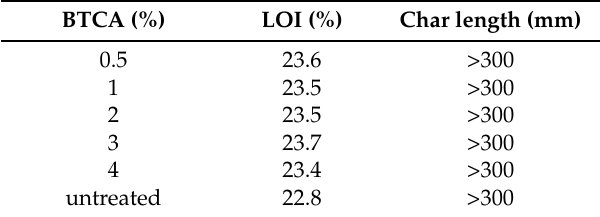
Table 2. The limiting oxygen index (LOI) and vertical burning flammability of the Nomex ® /cotton blend fabric treated with BTCA, cured at 170 ◦ C for 3 min and finally subjected to one home laundering. BTCA (%) LOI (%) Char length (mm) 0.5 23.6 >300 23.5